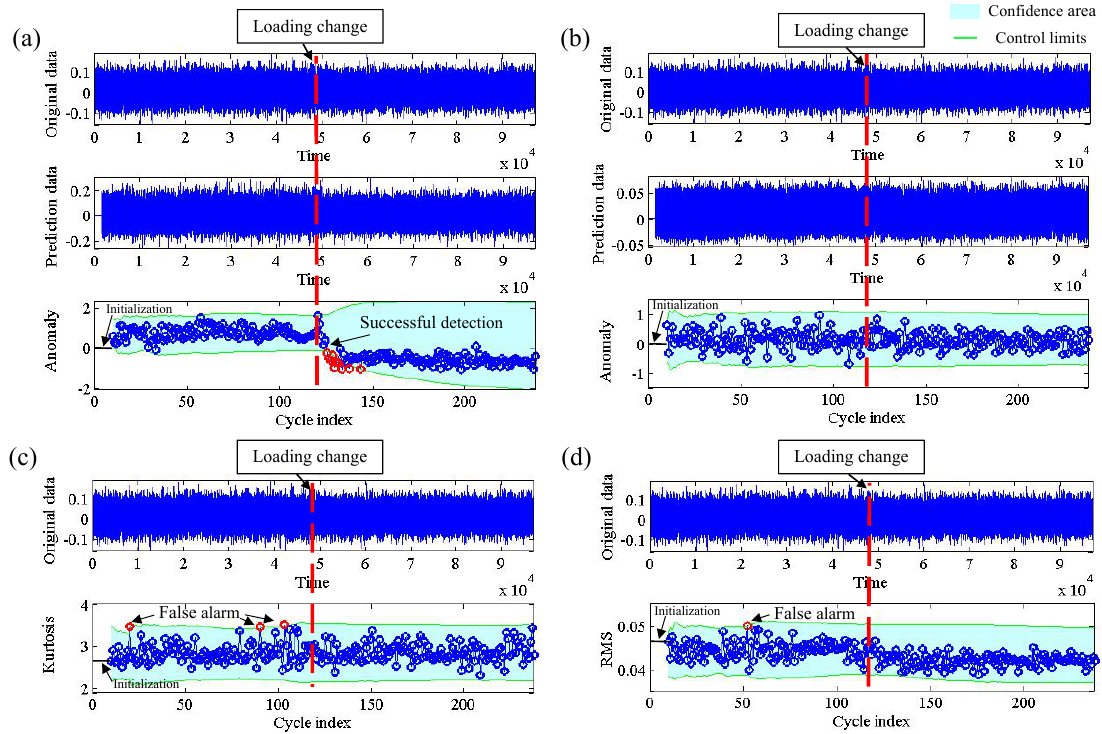
Figure 3. An example of change detection of load condition change from 1 hp to 2 hp. ( a ) DE model; ( b ) ARIMA model; ( c ) kurtosis; ( d ) RMS.